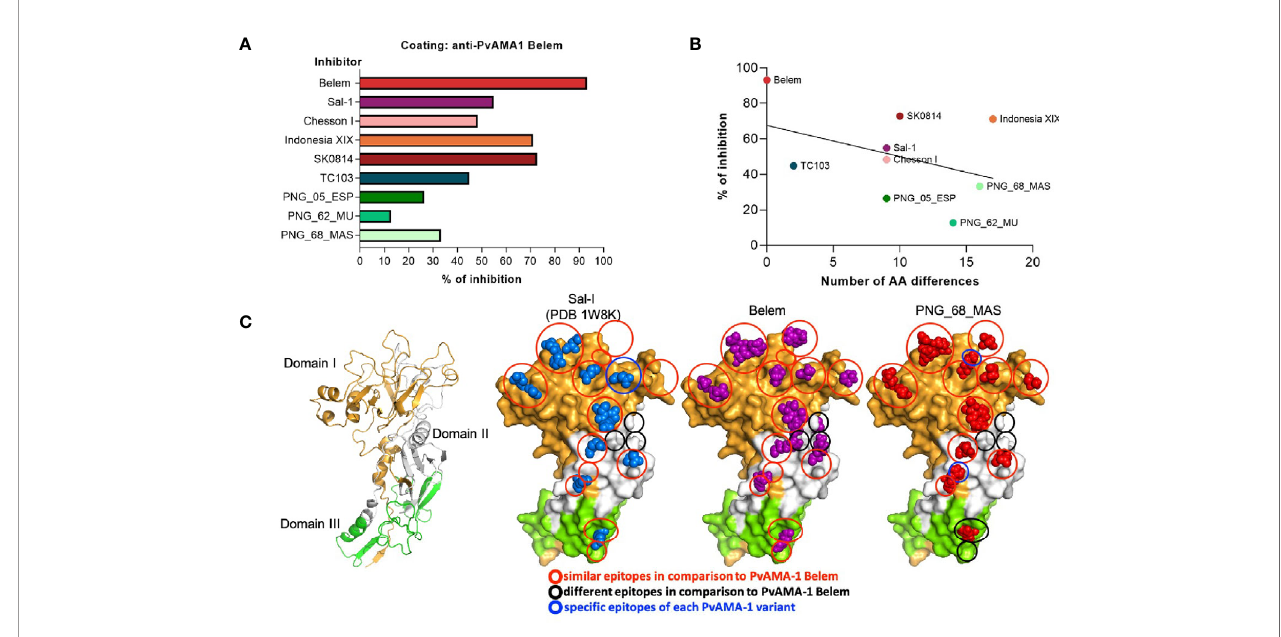
FIGURE 5 | In fl uence of distinct PvAMA-1 polymorphisms on antibody recognition. (A) Inhibition percentage of PvAMA-1 Belem recognition by anti- PvAMA-1 Belem antibodies preincubated with other variants. (B) Correlation between the inhibition percentage of PvAMA-1 Belem recognition by anti- PvAMA-1 Belem antibodies preincubated with other variants and the number of different amino acids compared to the Belem variant (p-value = 0.28). (C) Tertiary protein structure models of three different Pv-AMA-1 isolates based on the crystal structure of the Sal-1 isolate (PDB ID: 1W8K). The domains are represented in gold (domain I), white (domain II) or green (domain III). The epitope residues are shown in blue (Sal-1), purple (Belem) or red (PNG_68_MAS). Red circles represent similar epitopes in comparison to Belem, black circles represent different epitopes and blue circles represent speci fi c epitopes to each Pv-AMA-1